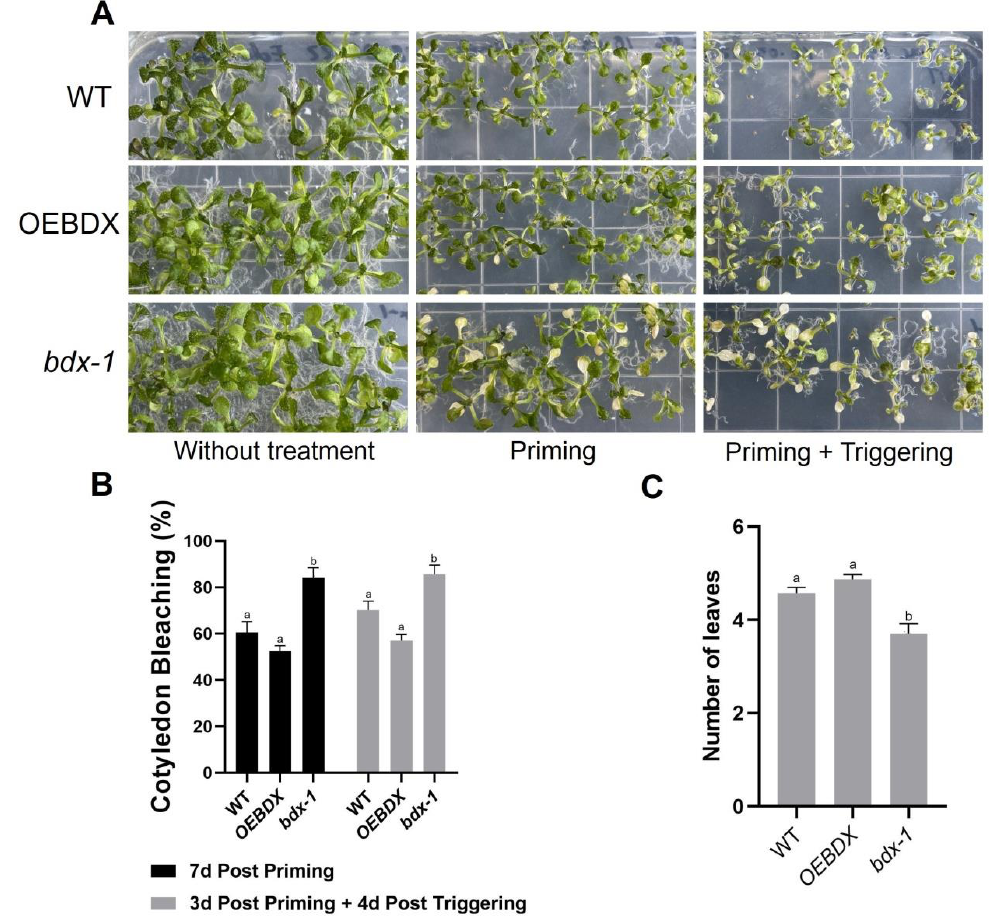
Figure 2. Phenotypic changes of WT, bdx -1, and OEBDX seedlings during thermotolerance and thermomemory. ( A ) WT Col-0, bdx -1, and OEBDX seedlings were grown on MS medium. Seedlings with two leaves were subjected to priming treatment (T 0 P). Seedling phenotypes of control, 7d post priming and 3d post priming, and 4d post triggering are shown. ( B ) The bleaching cotyledon phenotype was quantified in seedlings shown in ( A ) and represented as a percentage. ( C ) Leaves observed at 4d post triggering. Error bars indicate SEM (n = 3). An amount of 10 – 12 seedlings constituted each biological replicate. For cotyledon bleaching, statistical analyses were performed using arcsine conversion of percentages. Different letters indicate significant differences calculated using one-way ANOVA with post-hoc Tukey’s test ( p < 0.05).